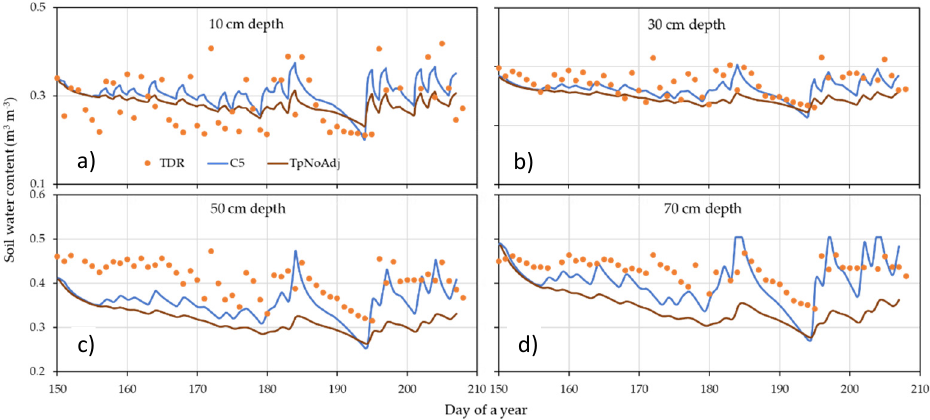
Figure 8. Comparison between measured (TDR) and simulated soil water content at five depths (from a to d ) under the C5 approach and with the “TpNoAdj” exercise described in the text.